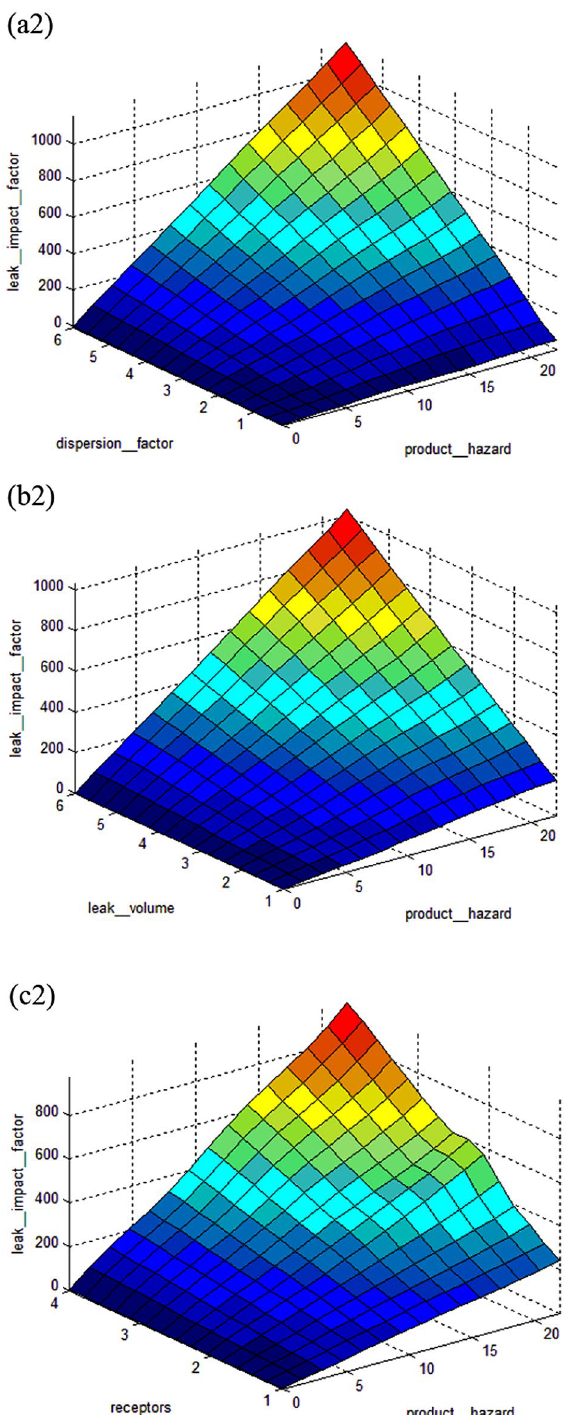
Figure 8. Control surface of leak impact factor on ( a2 ) dispersion factor and product hazard; ( b2 ) leak volume and product hazard; ( c2 ) receptors and product